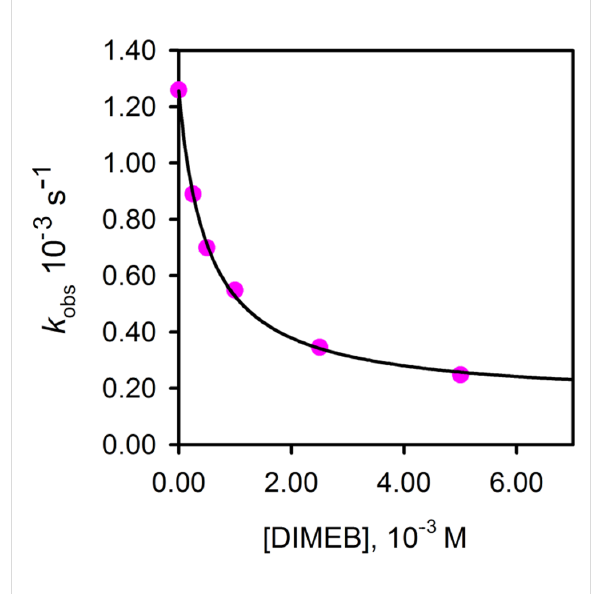
Figure 10: Plot of k obs versus [DIMEB] for the hydrolysis reaction of fenitrothion with HO – at different concentrations of DIMEB. T = 25 °C, [NaOH] = 0.5 M, ionic strength = 1 M (NaCl). Solvent: water with 2% 1,4-dioxane. The line was drawn by using the data calculated for k 0 , k 2 and K 2 in Equation